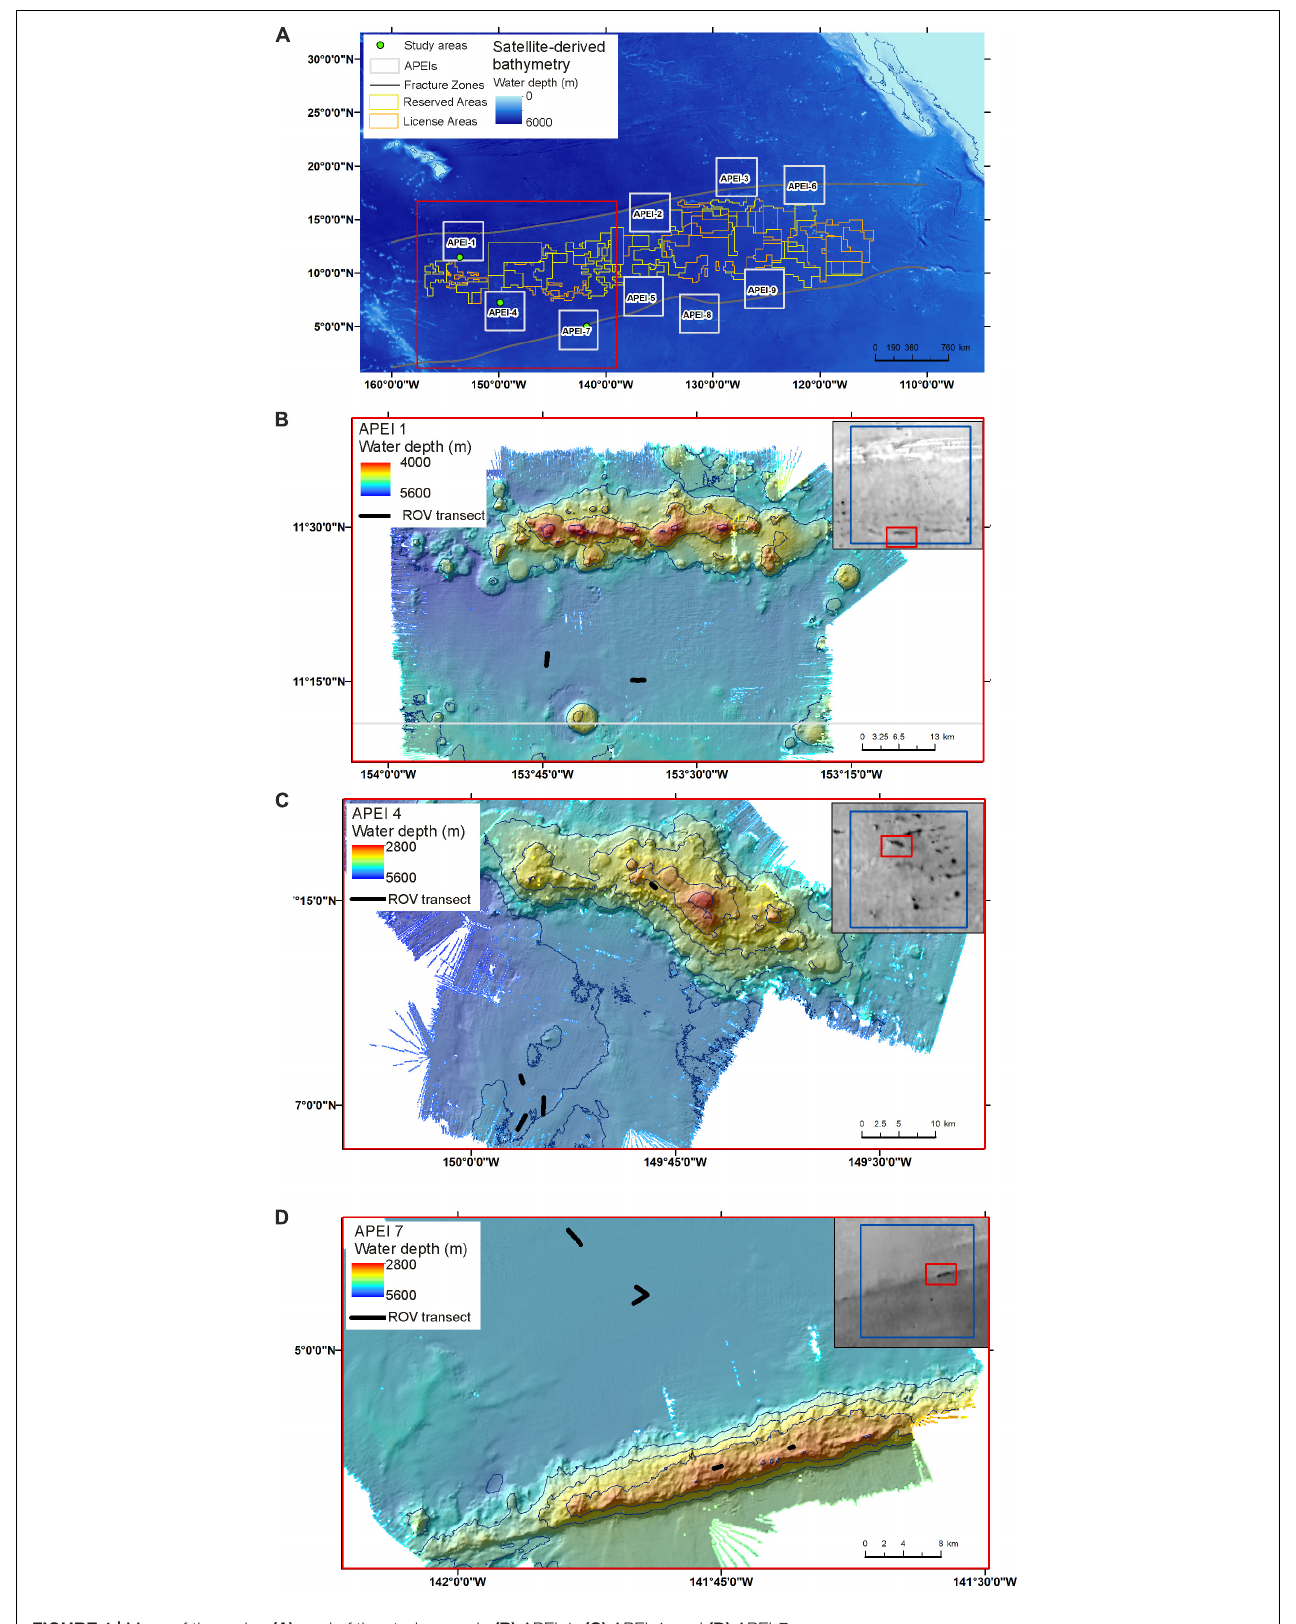
FIGURE 1 | Maps of the region (A) , and of the study areas in (B) APEI-1, (C) APEI-4, and (D) APEI-7.